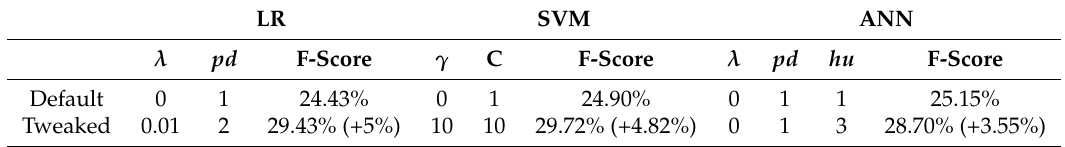
Table 5. F-Score results of parameters for LR, SVM, and ANN for the multi-class problem. LR SVM ANN λ pd F-Score γ C F-Score λ pd hu F-Score Default 0 1 24.43% 0 24.90% 25.15% Tweaked 0.01 28.70%